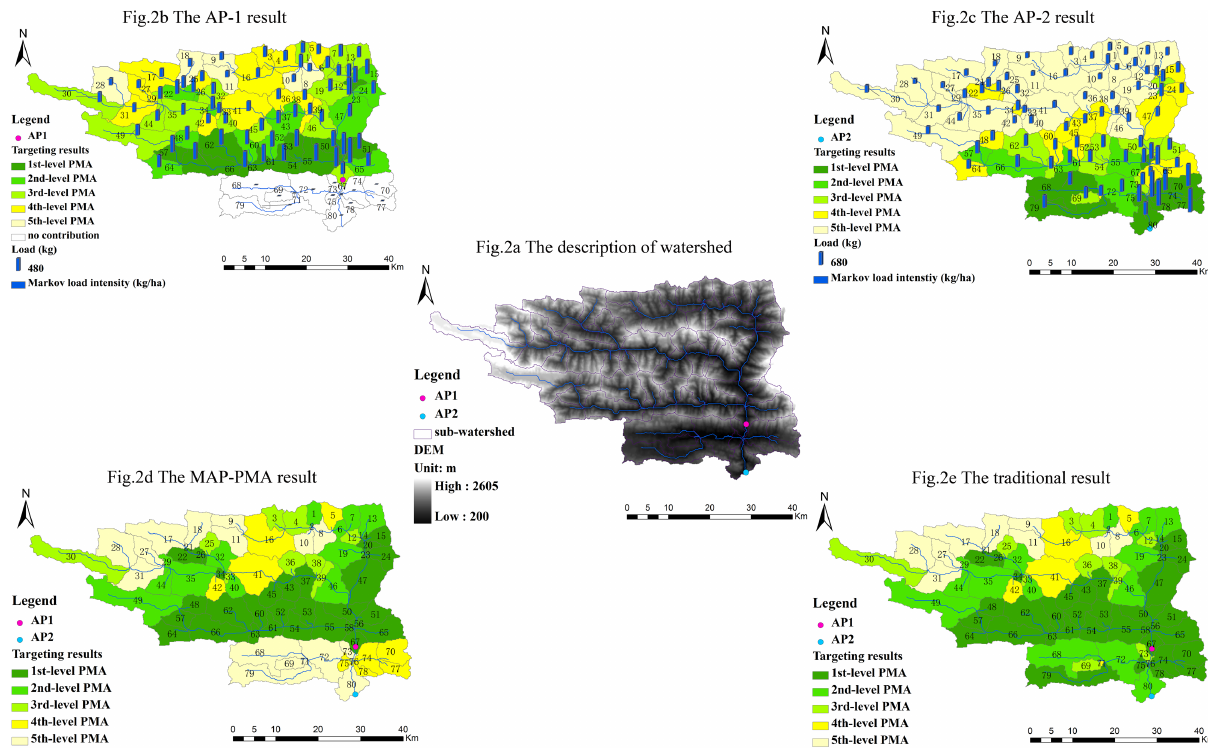
Fig. 2 The targeting results of the MAP-PMA, the AP-1, the AP-2, and traditional approach Fig. 2. The targeting results of the MAP-PMA, the AP-1, the AP-2, and traditional